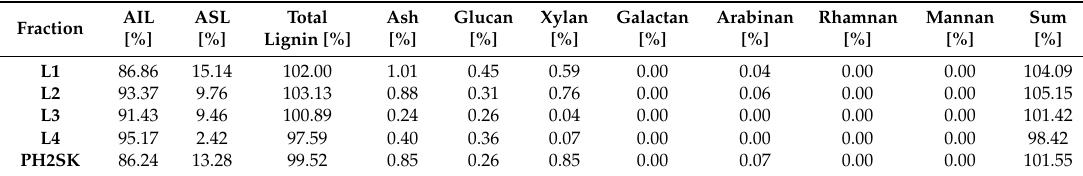
Table 2. Compositional analysis according to National Renewable Energy Laboratory (NREL) procedure of kraft lignin fractions (L1 to L4, purified via solvent extraction and PH2SK, isolated at pH2 without further